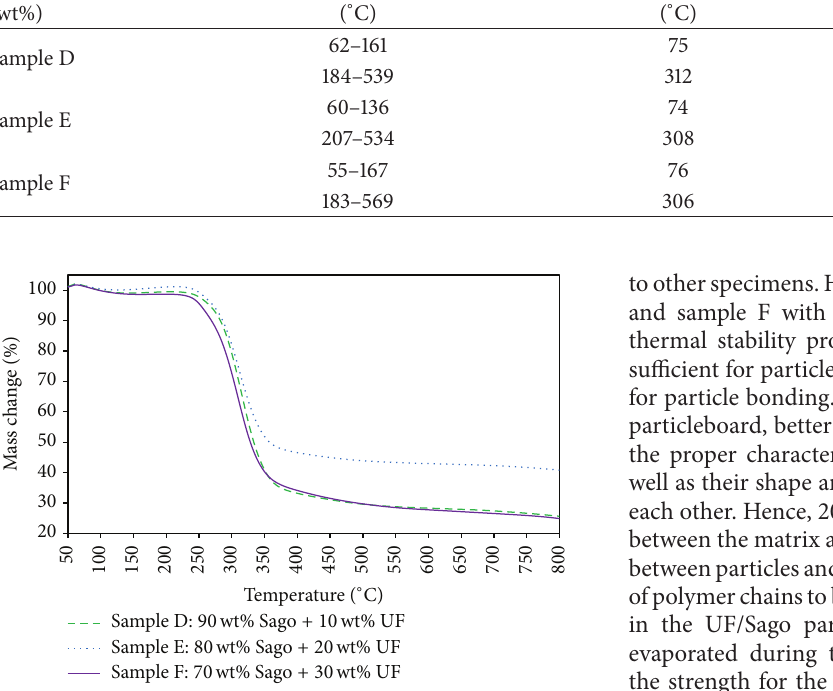
Figure 12: Sago/UF Sample with different weight fraction analysis by